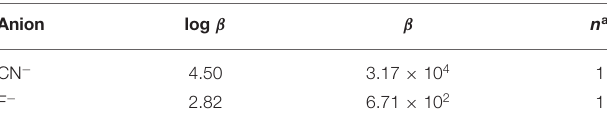
TABLE 1 | Deprotonation constants of 1 with CN − and F − ions in CH 2 Cl 2 at 298K. Anion log β β n a CN − 4.50 3.17 × 10 4 1 F − 2.82 6.71 × 10 2